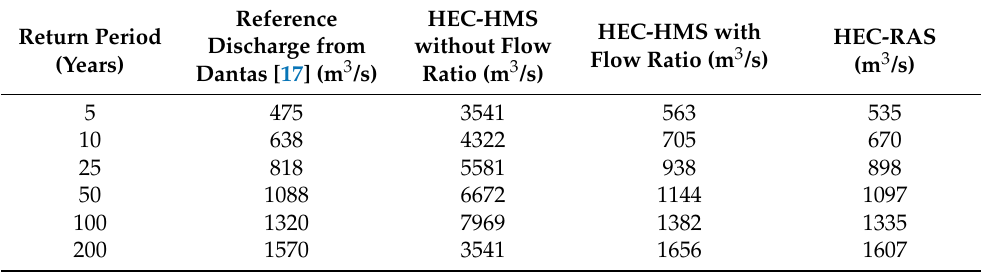
Table 3. Maximum discharges at Palmares station simulated without the Serro Azul